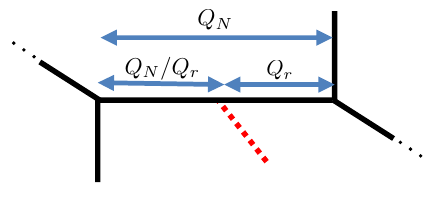
Figure 4 . A part of the web diagram in (cid:12)gure 3